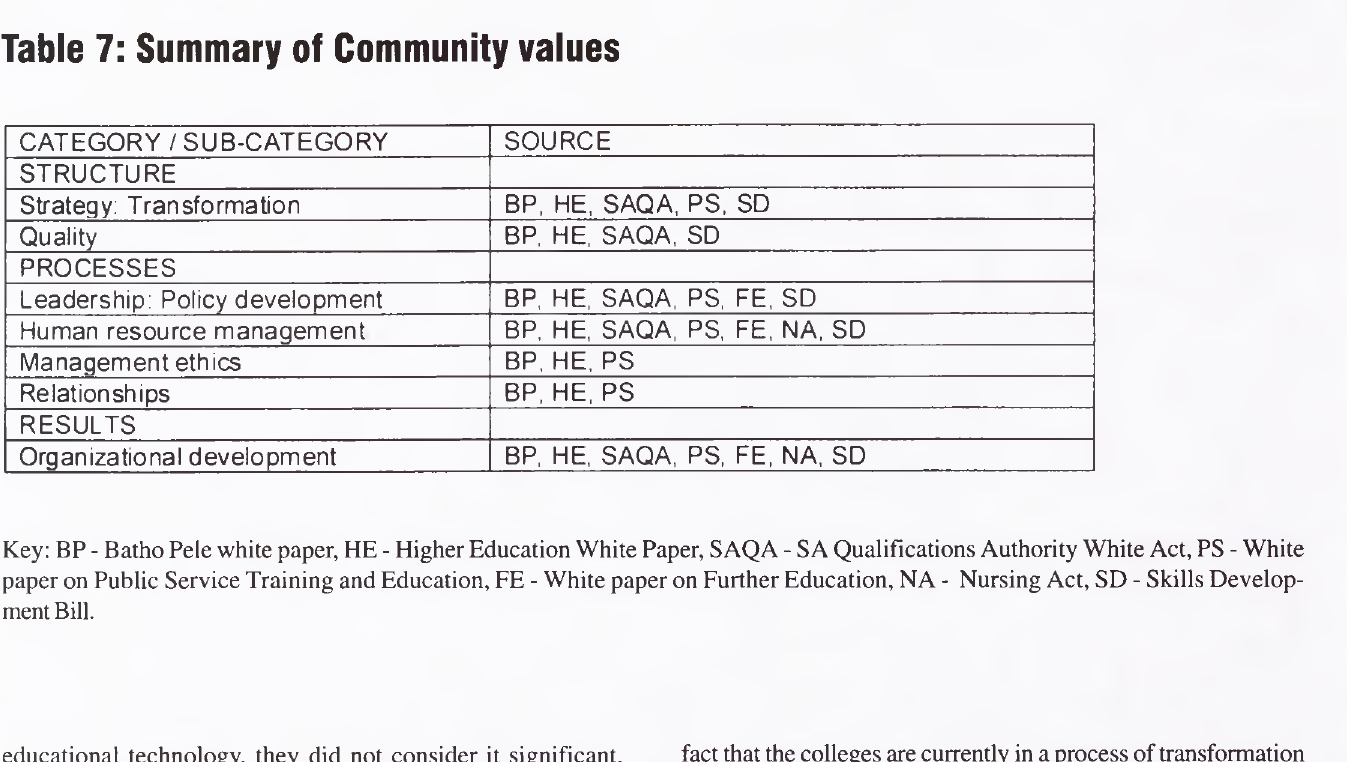
Table 7 : Summary of Community values CATEGORY /